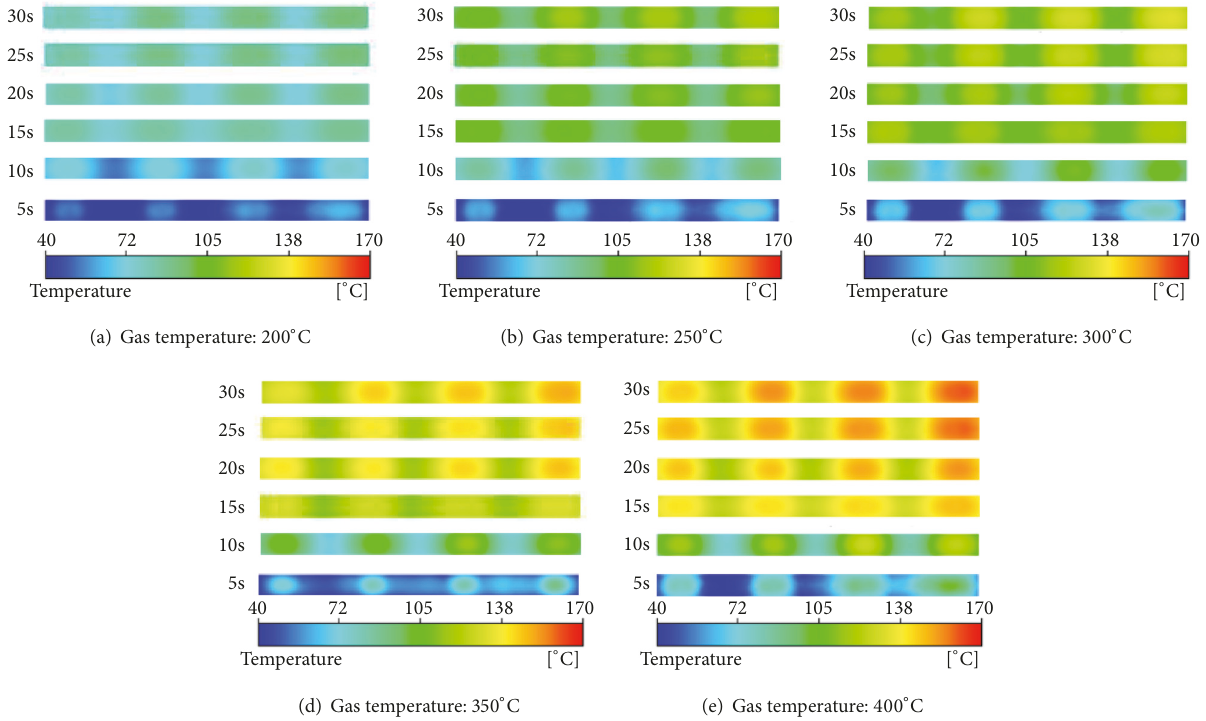
Figure 11: Temperature distribution at the cavity surface of the melt flow length mold after 30 s heating at different gas temperatures.